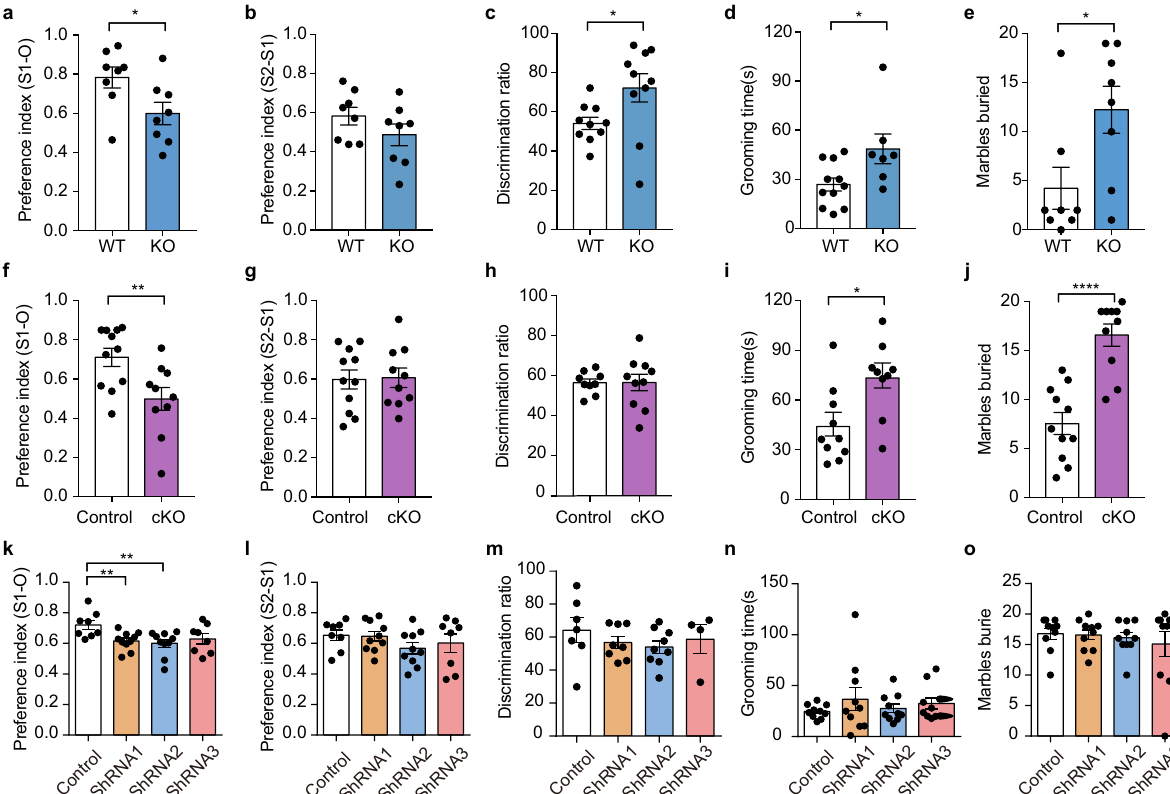
Fig. 1 IP3R2 null mutant (IP3R2 KO) and Aldh1L1-CreER:IP3R2 loxp/loxp (IP3R2 cKO) mice exhibit ASD-like behaviors. a , b Impaired social interaction in IP3R2 KO mice in the three-chamber test. a Social preference (object versus stranger 1, S1-O, t 14 = 2.353, P = 0.0338, n = 8). b Social novelty recognition (S2-S1, t 14 = 1.341, P = 0.2013, n = 8). c Enhanced recognition memory in IP3R2 KO mice in the novel object recognition test ( U = 20, P = 0.0232, n = 10). d , e Increased repetitive behavior in IP3R2 KO mice in the self-grooming test ( d t 18 = 2.471, P = 0.0251, n = 11/7) and the marble-burying test ( e t 14 = 2.488, P = 0.0261, n = 8). f , g Same as ( a , b ) but for IP3R2 cKO mice ( f t = 2.873, P = 0.0097, n = 11/10; g t = 0.9303, P = 0.3639, n = 11/10). h Same as ( c ) but 19 19 for IP3R2 cKO mice ( U = 40, P = 0.7197, n = 9/10). i , j Same as ( d , e ) but for IP3R2 cKO mice ( i t 17 = 2.845, P = 0.0112, n = 10/9; j t 19 = 5.633, P = 0.2×10 − 4 , n = 11/10). k , l Same as ( a , b ) but for IP3R2 knockdown C57BL/6J mice ( k Control vs. ShRNA1, t = 0.3078, p = 0.0072, n = 8/10; Control vs. shRNA2, 16 t = 0.3065, p = 0.0074, n = 8/10; l Control vs. shRNA1, t = 0.1498, p = 0.8828, n = 8/10; Control vs. shRNA2, t = 1.704, p = 0.1076, n = 8/10). m Same 16 16 16 as ( c ) but for IP3R2 knockdown C57BL/6J mice. n , o Same as ( d , e ) but for IP3R2 knockdown C57BL/6J mice. WT, wild-type mice; KO, IP3R2 null mutant mice; control, Aldh1L1-CreER mice; cKO, IP3R2 cKO mice. Data are presented as mean±SEM; two-tailed unpaired t test ( a , b , d , e , f , g , i , j , k , l , m ); Mann – Whitney U-test ( c , h , n , o ). * P <0.05, ** P <0.01, **** P <0.0001. Each data point represents an individual mouse. Comparisons with no asterisk had a P >0.05 and were considered not signi fi cant. Source data are provided as a Source data fi astrocytes (Supplementary Fig. 5c, d). These data suggest a spe- ci fi c loss of IP3R2 in astrocytes results in no signi fi cant change in astrocyte reactivity and synaptic and neuronal morphology.